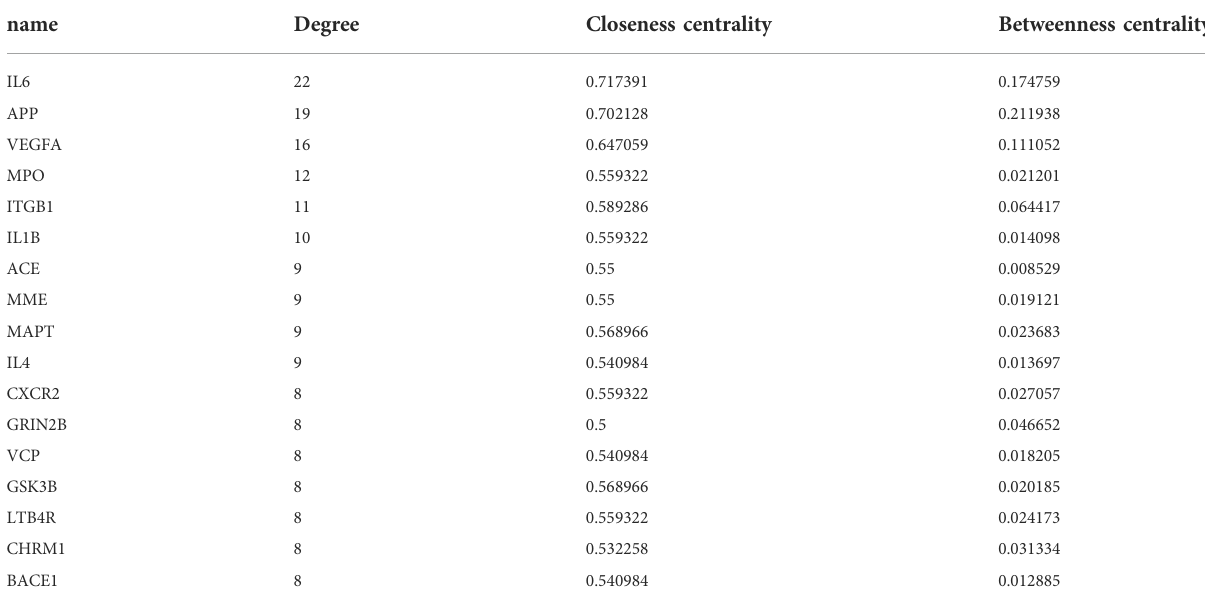
TABLE 3 Topological parameters of the targets.